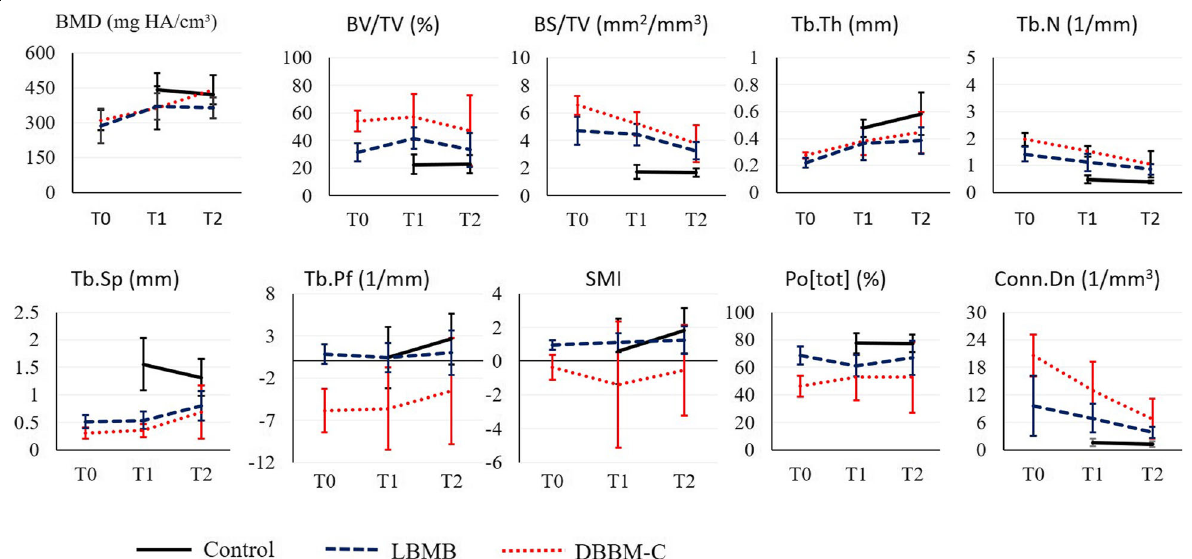
Fig. 3 Morphometric analysis of the deproteinized bovine bone mineral with 10% collagen (DBBM-C) and deproteinized bovine medullary bone (LBMB) graft blocks at baseline (T0), in the region of the critical defects after 3 months (T1) and after 6 months (T2) post-operative follow-up. In the control group, the bone defects were left untreated. Morphometric parameters were subdivided in density-related parameters: bone mineral density (BMD in mg HA/cm 3 ); quantity-related: bone volume fraction (BV/TV in %), bone surface density (BS/TV in mm − 1 ), trabecular thickness (Tb.Th in mm); and structural-related parameters: trabecular number (Tb.N in 1/mm), trabecular separation (Tb. Sp in mm), trabecular pattern factor (Tb.Pf in 1/mm), structural model index (SMI), connective density (Conn.Dn in 1/mm 3 ), total porosity percentage (Po[tot] in